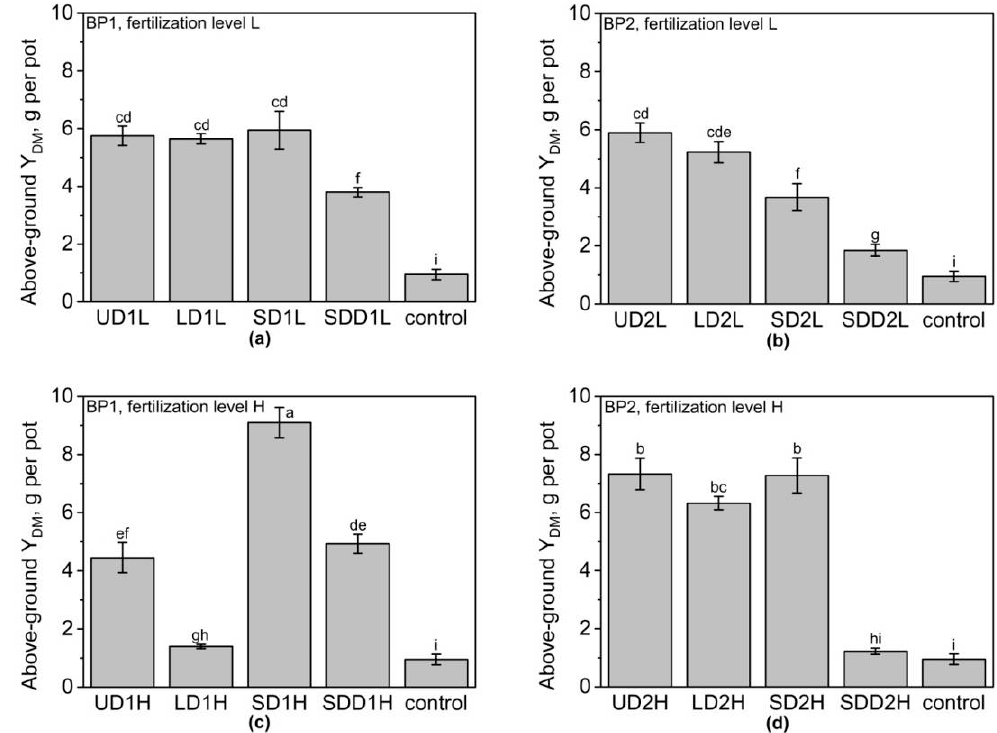
Figure 2. Above-ground biomass yield Y DM of different treatments: ( a ) Treatments based on manure as feedstock from BP1 with fertilization level L; ( b ) Treatments based on energy crops as feedstock from BP2 with fertilization level L; ( c ) Treatments from BP1 with fertilization level H; ( d ) Treatments from BP2 with fertilization level H; (code see Table 1; n = 4, whiskers show standard deviation, different letters indicate significant differences, p = 0.05).